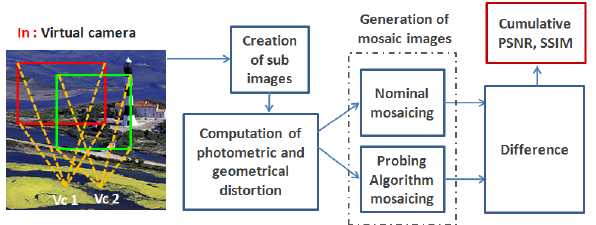
Figure 2. Virtual camera